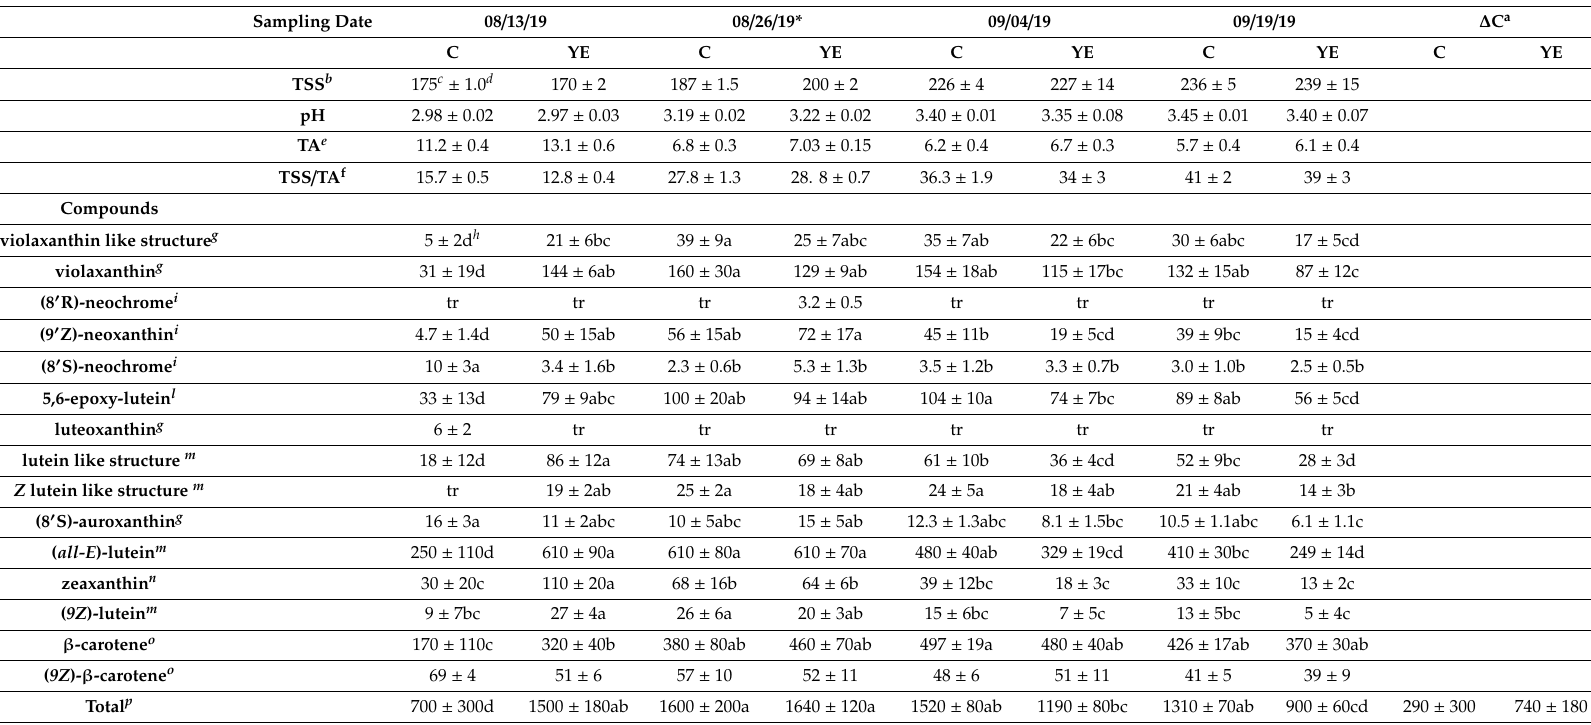
Table 3. Changes in carotenoid contents (expressed as µ g / kg of berries) in Primitivo grapes from v é raison to